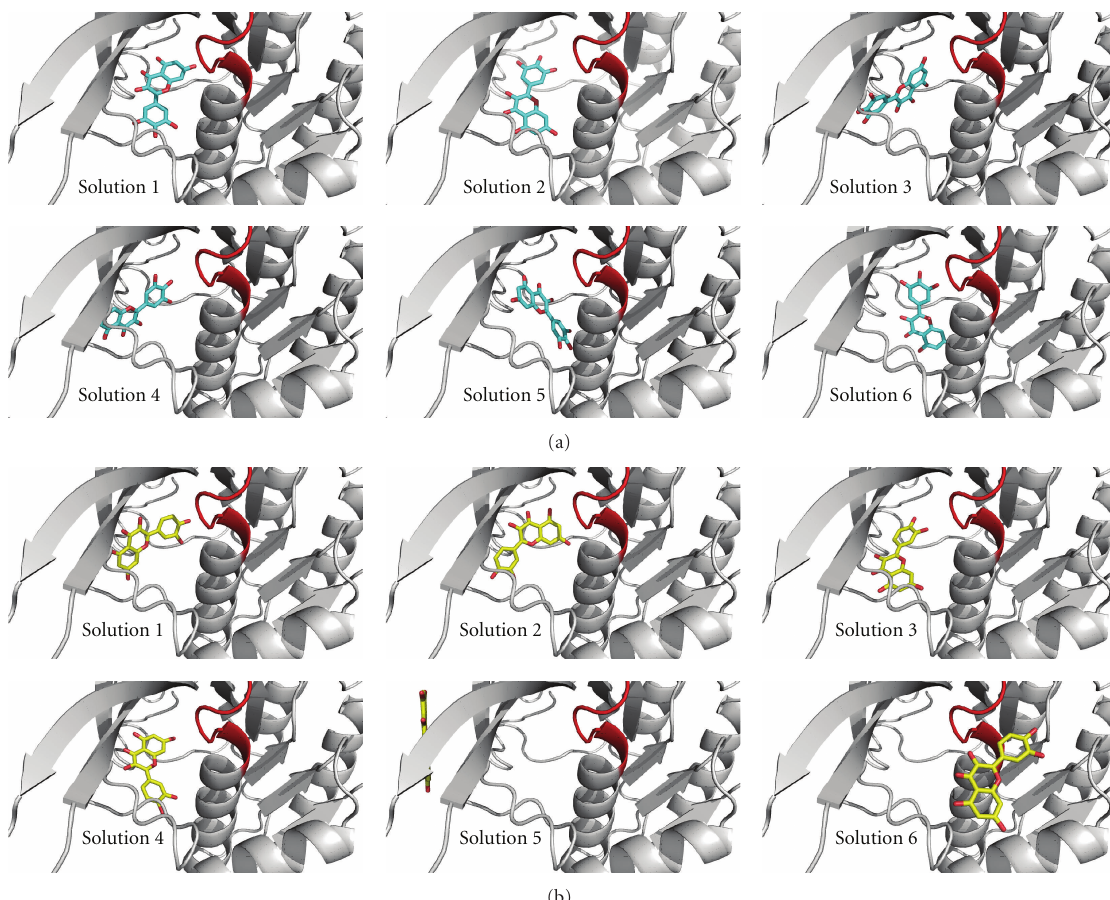
Figure 8: Representation of the docking models from PatchDock. The six docking models with the highest score for Kp DnaB ( Gk DnaB- based model) interacting with (a) Myr and (b) Que are shown. The Walker A motif (aa 232–238), a nucleotide binding site, is colored in red.